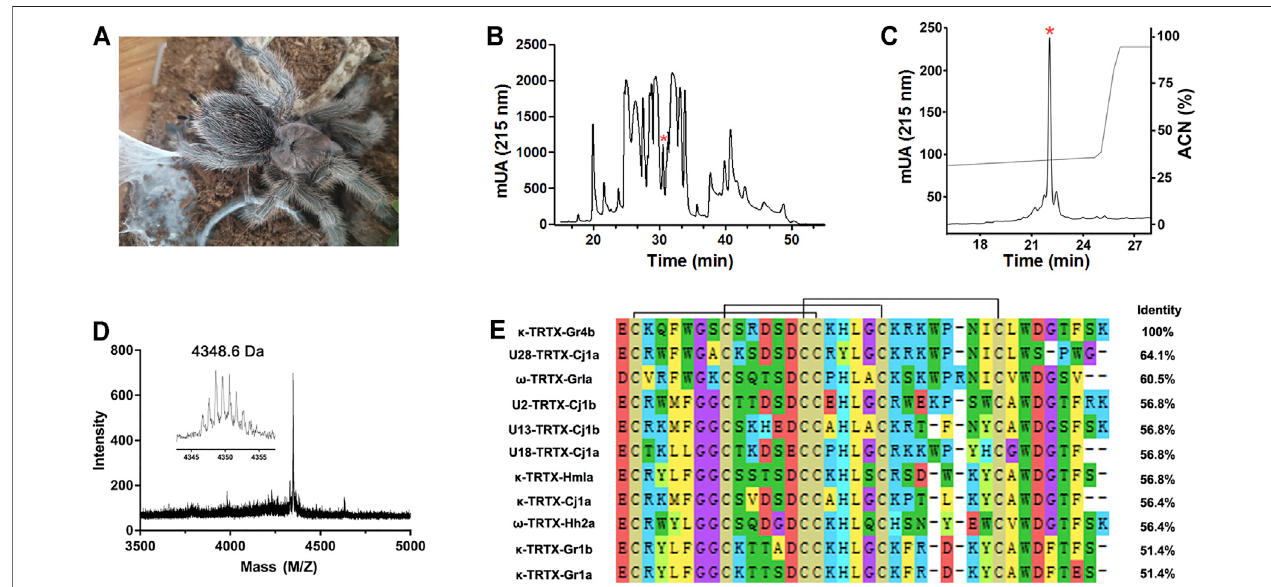
FIGURE1| Puri fi cationandidenti fi cationofGr4b. (A) ThespiderG. Grammostolarosea. (B) RP-HPLCpro fi leofcrudevenomfromspider Grammostolarosea .The asterisk indicated the peak containing Gr4b. (C) Gr4b was puri fi ed to homogeneity by analytical RP-HPLC. (D) MALDI-TOF MS spectrum showing a monoisotopic M+H + of 4348.6 Da. (E) Sequence alignment of Gr4b with similar toxins in NaSpTx family2; black lines show the disul fi de linkage.